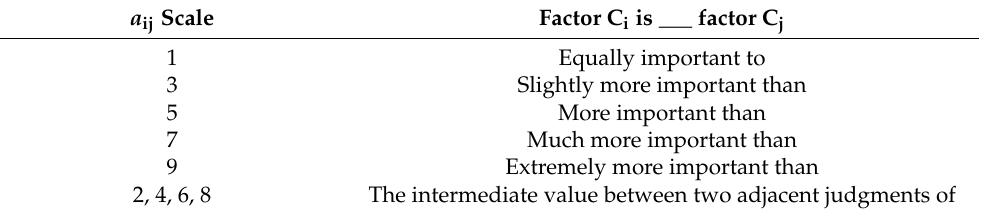
Table 6. Meaning of a ij